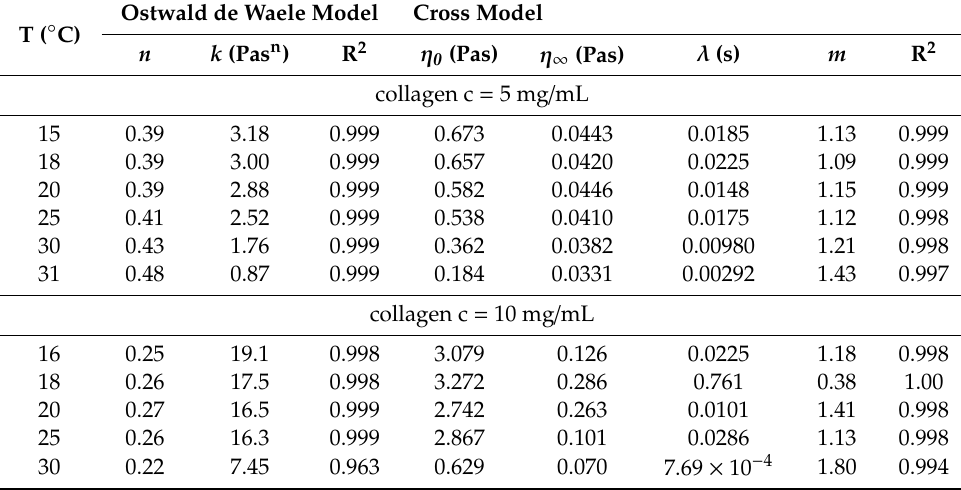
Table 1. The rheological parameters from the Ostwald de Waele model and Cross model for collagen solution as function of concentration and